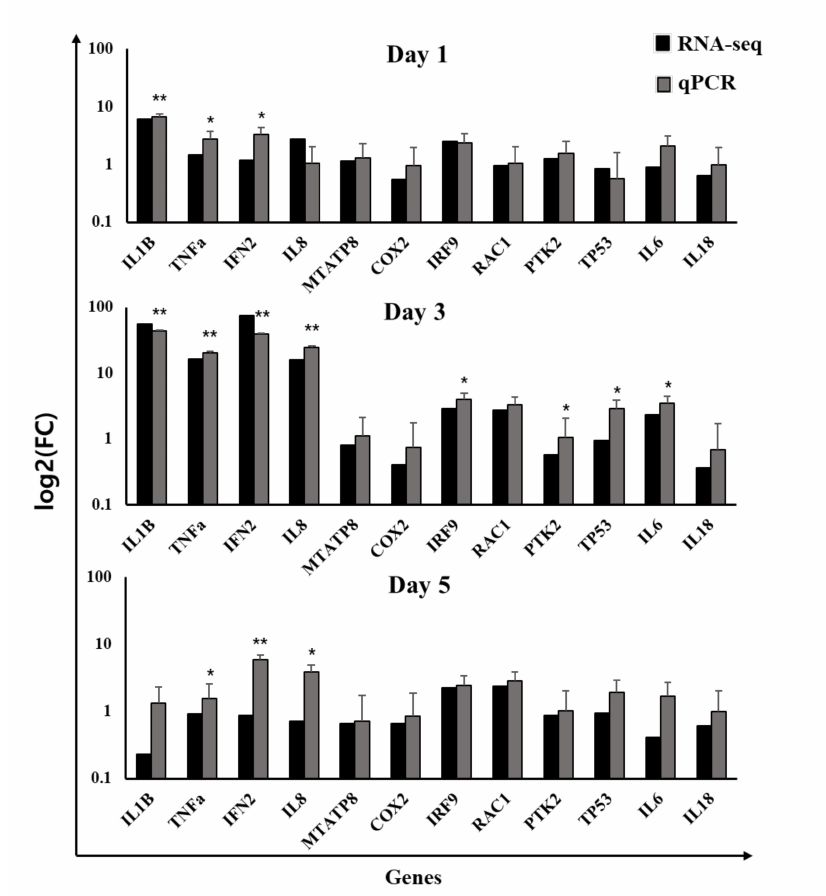
Figure 5. Expression level of 12 randomly selected genes validated by Q-PCR. The EF-1 α gene was used as an internal control, and each gene’s relative quantity of gene expression (fold change) was calculated comparatively. The asterisks indicate the level of significance based on an unpaired t -test (*, p < 0.05; **, p < 0.00; N = 8). IL-1 β , interleukin-1beta; TNF α , tumor necrosis factor-alpha; IFN2, Type I IFN 2; IL-8, interleukin-8; MT-ATP8, ATP synthase protein 8; COX2, cytochrome c oxidase subunit 2; IRF9, IFN regulatory factor 9; RAC1, Ras-related C3 botulinum toxin substrate 1; PTK2, protein kinase domain-containing protein; TP53, cellular tumor antigen p53; IL-6, Interleukin-6; IL-18,